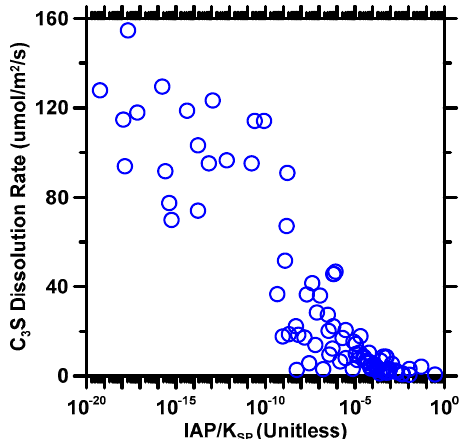
Figure 3. The correlation between the degree of undersaturation ( IAP / K sp ) and the dissolution rate of C 3 S. The x-axis shows in a logarithmic scale due to the small magnitude of the degree of under- saturation.